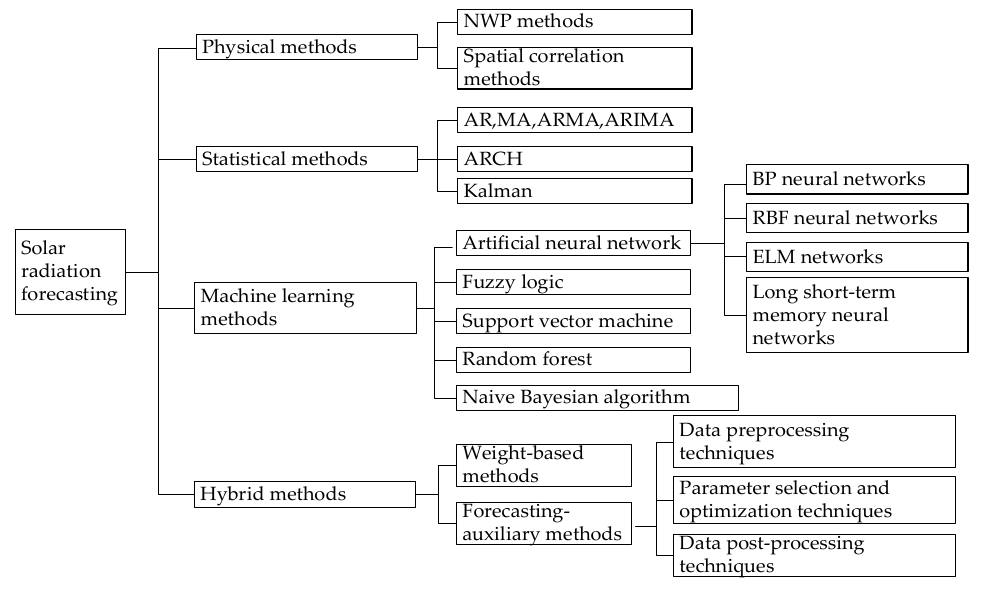
Figure 1. Available popular solar radiation forecasting methods.